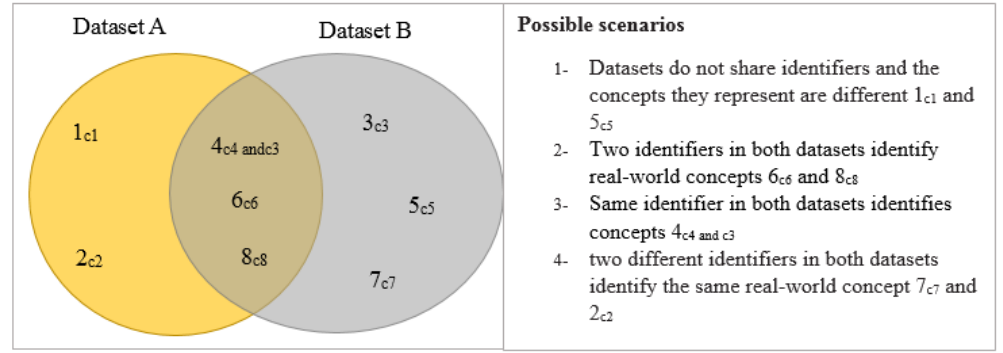
Figure 2. Dataset comparison (adopted from Colpaert et al. [27]).